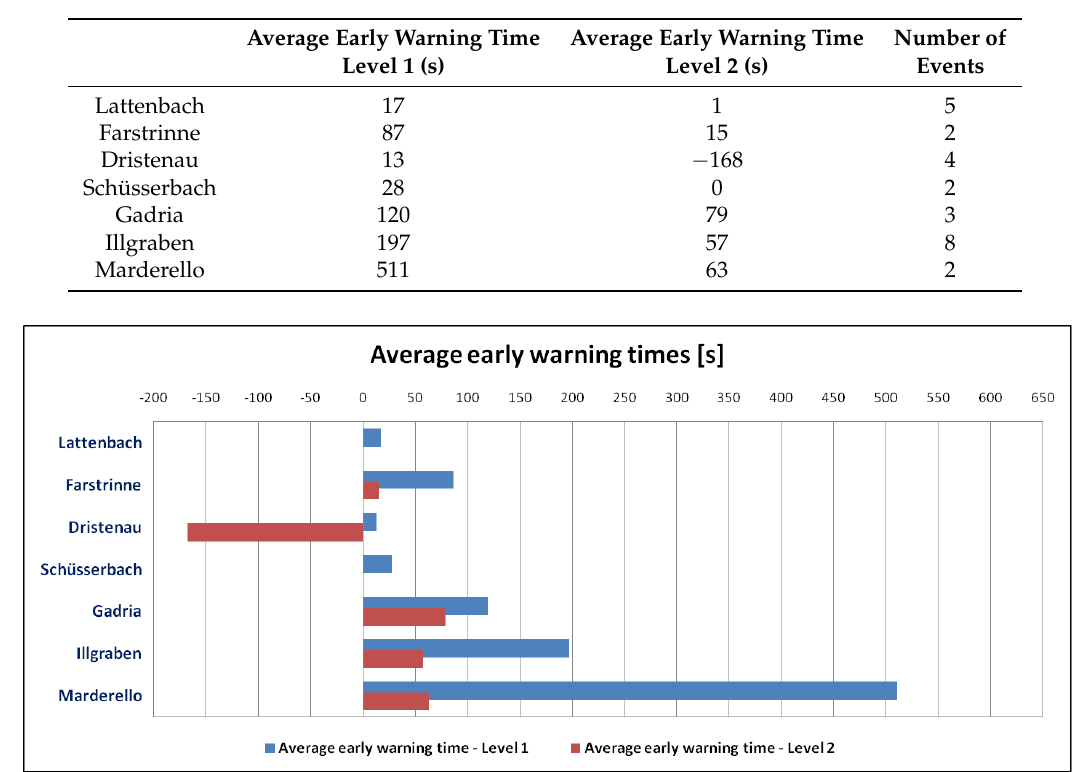
Figure 10. Overview average early warning times for all events listed in Table